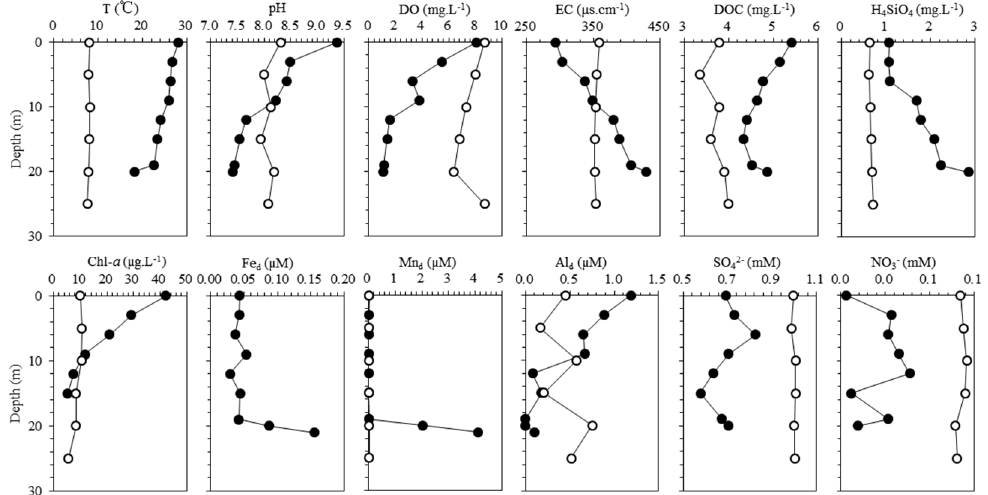
Figure 2. Depth profiles of environmental parameters and chemical data in the summer and winter in Hongfeng Lake.